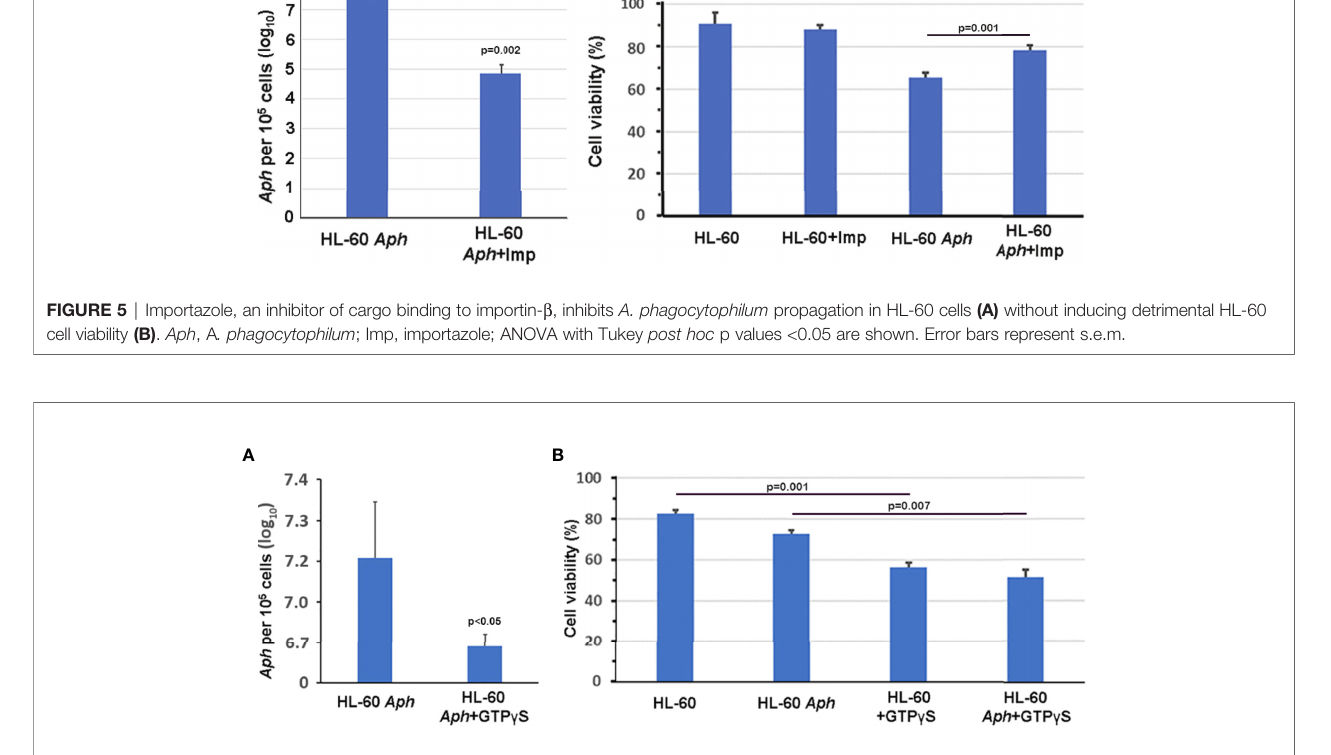
FIGURE 6 | GTP g S, a non-hydrolysable GTP analog that inhibits RanGTP/RanGDP-dependent nuclear translocation by importin- a / b and RaDAR mechanisms and likely many other cellular processes, signi fi cantly impairs A. phagocytophilum growth in vitro (A) without further compromising viability of infected HL-60 cells (B) . Aph , A . phagocytophilum ; Error bars represent